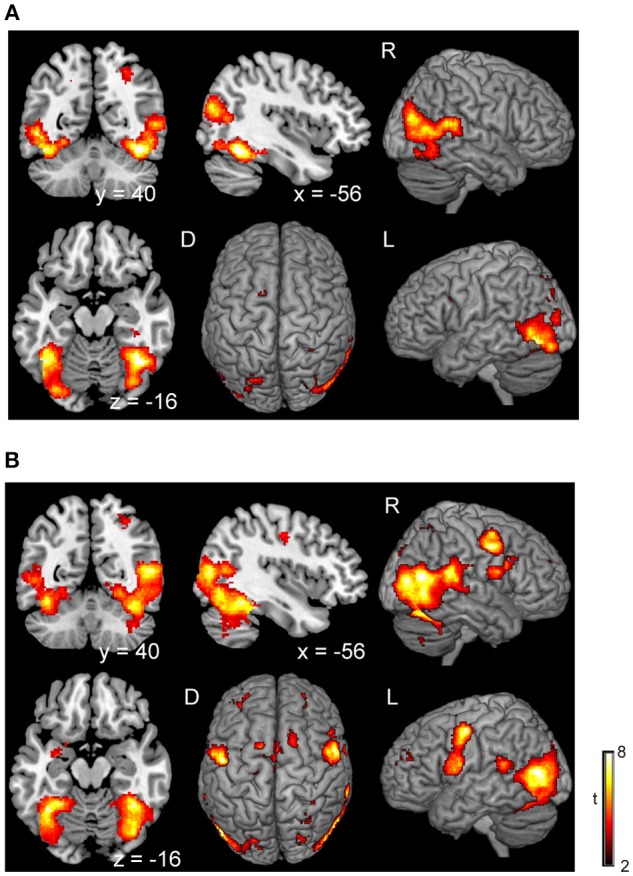
Comparison of the brain activity between forced and voluntary conditions in the stop and start conditions. The color on the brain images indicates the significant difference between the forced and voluntary conditions (stimuli-triggered > self-paced). (A) Stop condition, (B) start condition. The height and extent thresholds of brain activation were set at the P < 0.001 level (uncorrected) and a cluster-level FWE of 0.05, respectively. The scale for t-scores is shown alongside. The number and alphabetic characters indicate the XYZ coordinates in the Montreal Neurological Institute (MNI) space. The letters in the figure indicate the direction of each brain image (L, left; R, right; D, dorsal).